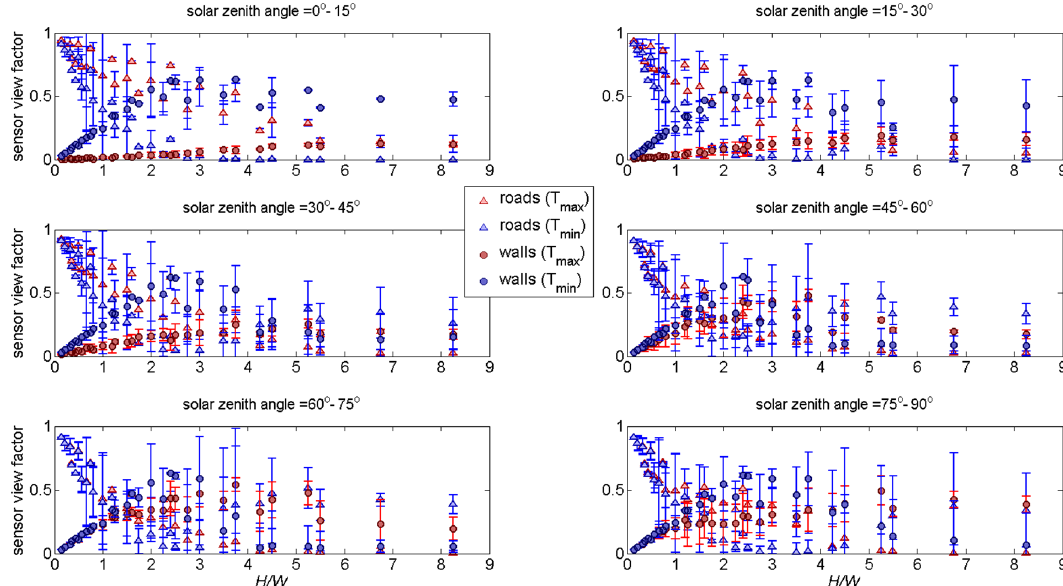
Figure 9. Total view factor from SUM sensor to roads and walls for T B , max and T B , min view angles as a function of H/W for six solar zenith angle ranges (data from all latitudes and all hours between 1200 LST and 2000 LST, inclusive). Median (symbols) and interquartile range (error bars) for each value of H/W are plotted for clarity.